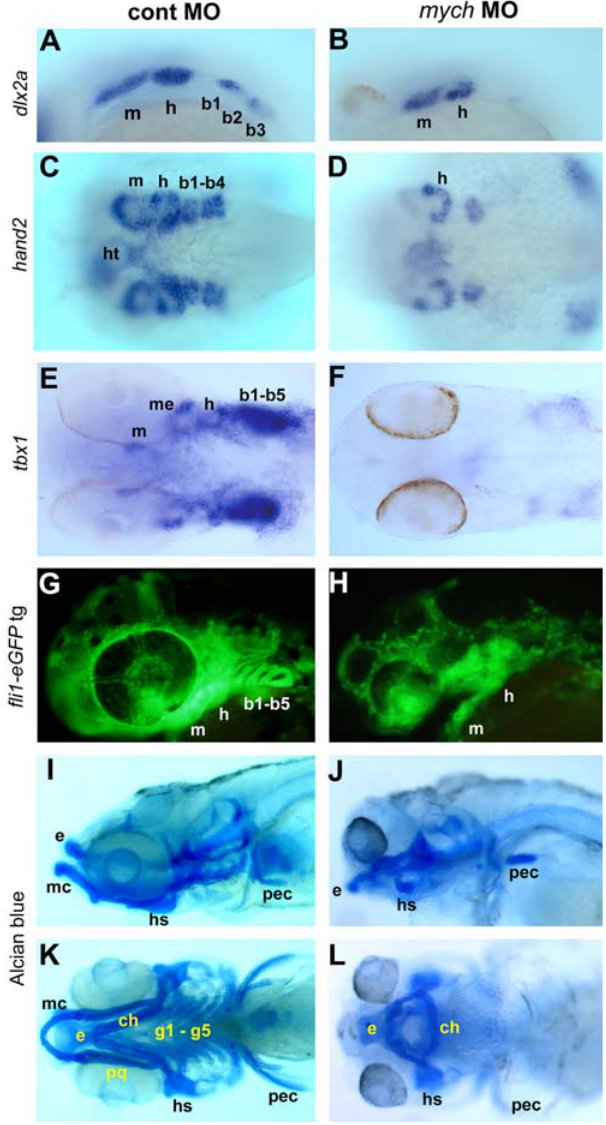
Figure 7. Multiple defects in pharyngeal arch development caused by mych MO. Control MO (A,C,E,G,I,K) and mych UTR MO- injected embryos (B,D,F,H,J,L). A–B. Lateral view of dlx2a expression in mych UTR MO-injected embryos at 26hpf (B). C–D. Ventral view of expression of hand2 at 36hpf. E–F. Ventral view of tbx1 expression at 45hpf. G–H. Lateral view of fli1-eGFP transgenic line at 40hpf. I–L. Lateral (I,J) and ventral (K,L) views of Alcian blue stained day 5 control (I,K) and mych UTR MO-injected embryos (J,L). ch, ceratohyal, b, branchial arch; e, ethmoid plate; g, gill arches; h, hyoid arch; hs, hyosymplectic; ht, heart; m, mandibular arch; mc, Meckel’s cartilage; me, mesoderm; pec, pectoral fin; pq, palatoquadrate.